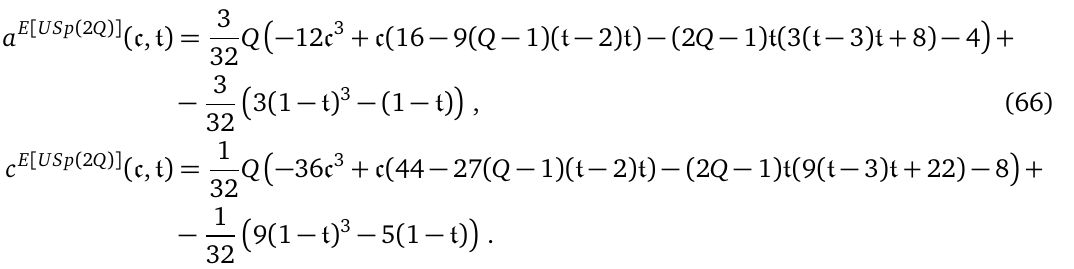
) tubes we obtain a torus with n units of , 1 , 1 , 1 , 1 , 1 , 1 , 1 2 2 2 2 2 2 2 2 × E × U ( 1 ) . Here we have n = t 7